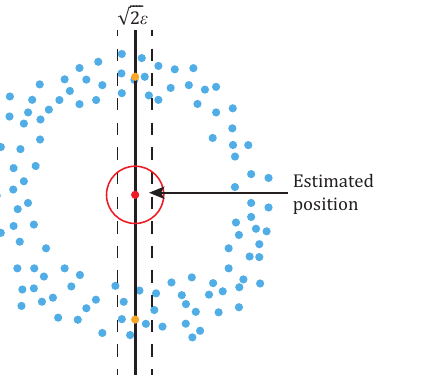
Fig. 2 An arbitrarily shaped cluster.